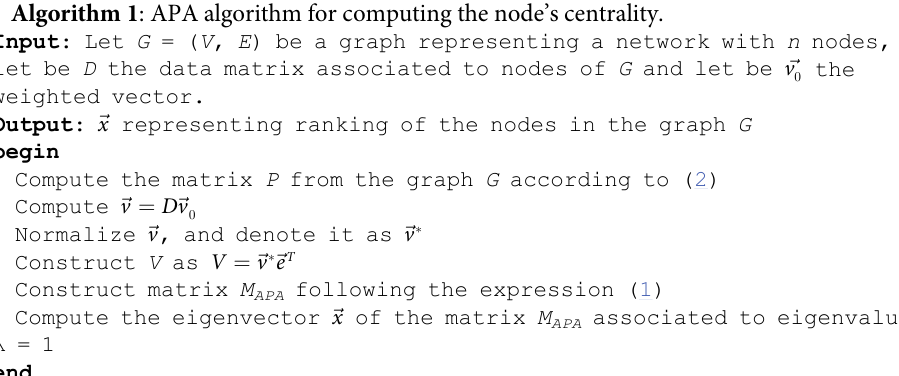
Algorithm 1 : APA algorithm for computing the node’s